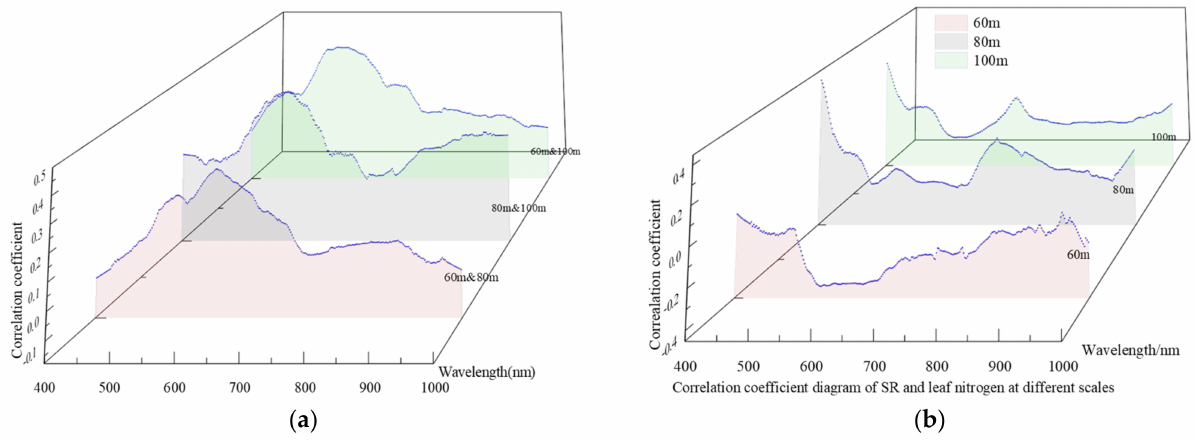
Figure 7. Correlation coefficient between hyperspectral reflectance at various heights ( a ) and correla- tion coefficient between SR and leaf nitrogen content (LNC) ( b